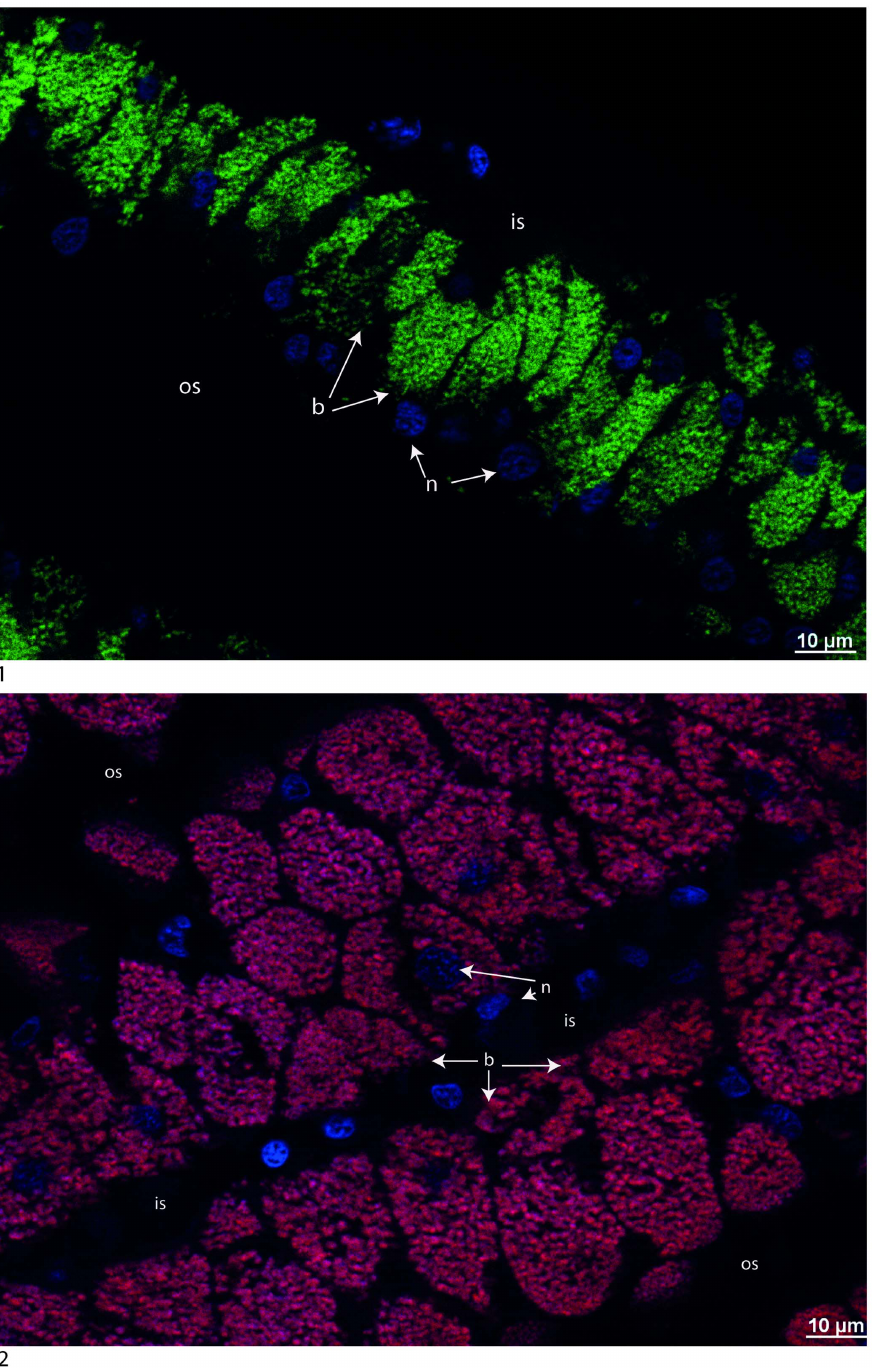
Figure 5. Cross-sections of gills dissected from C.regab (217-V4) (1) and L.chuni (225-V6) (2) and hybridized with Creg821 (Cy3, stained in green) and Lchun821 (Cy5, stained in red) FISH probes, and DAPI counterstained (in blue). For the individuals shown, only a single 16S rRNA symbiont phylotype was identified through PCR. Specific probes and DAPI (2) do not overlap perfectly, possibly due to low activity in some bacteria. b: bacteriocyte, n: nucleus, os: outer lamellar space, is: intralamellar space.